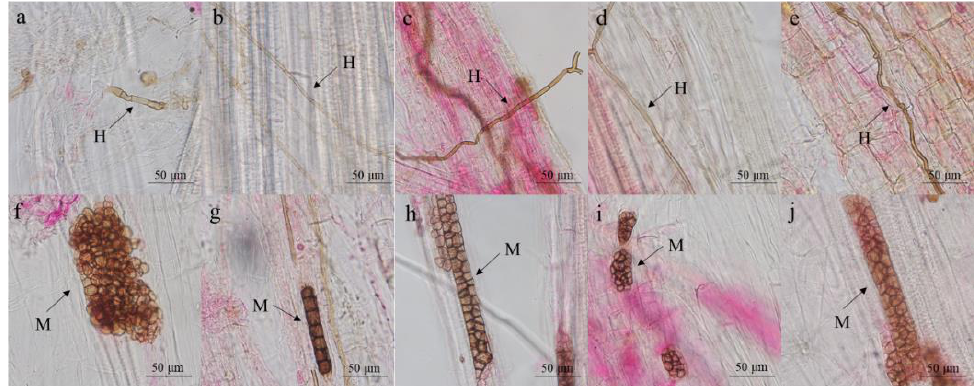
Figure 1. Typical DSE hyphae and microsclerotia in the inoculated seedlings. H, hyphae; M, microsclerotia. ( a – e ), DSE hyphae in the inoculated wheat roots. ( f – j ), DSE microsclerotia in the inoculated wheat roots.